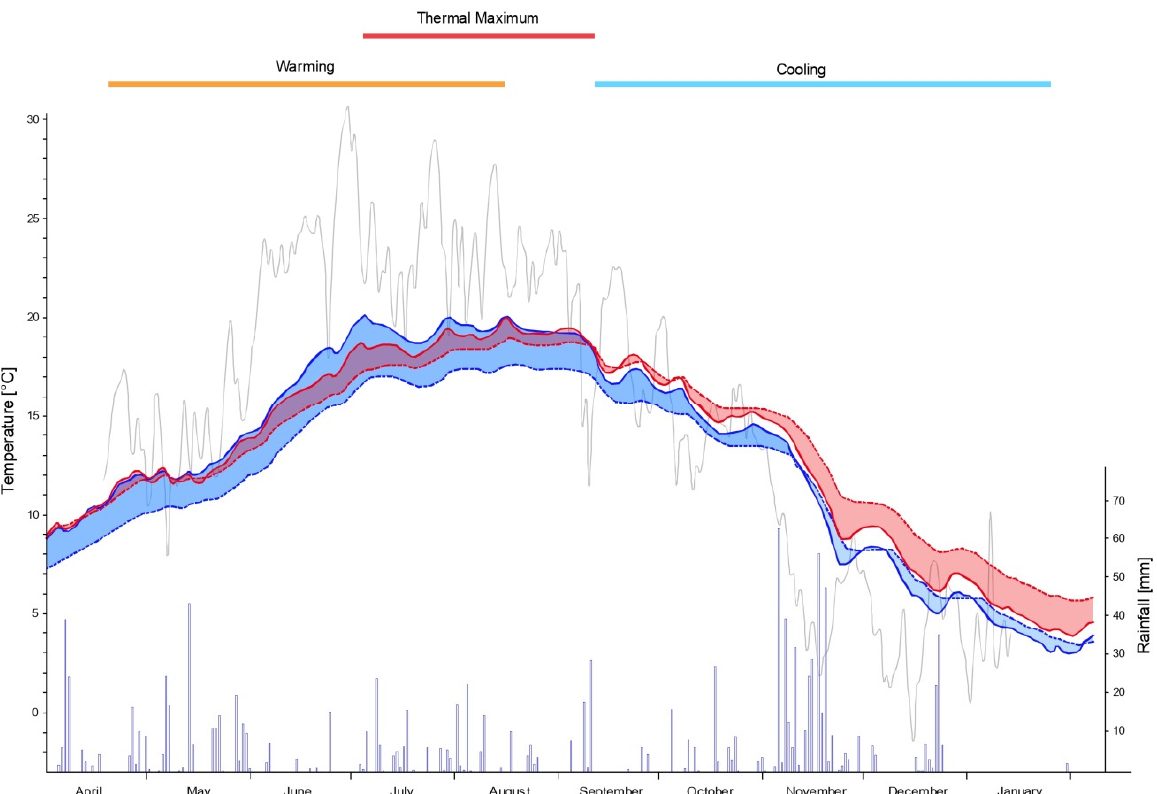
Figure 5. Annual thermal cycle in the subsoils during the April–January period. The curves represent vineyard V1 (blue) and V7 (red) at a depth between 80 cm (solid line) and 120 cm (dashed line). The grey curve is air temperature, and the bars represent the amount of rainfall. Note that the V1 subsoil, which is less wet, becomes warmer more easily in summer and colder more easily in autumn. It is also more sensitive to rainy events and demonstrates a more evident and stable decrease in temperature throughout the pre-harvest period. Vineyards are harvested in mid-October.